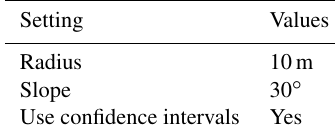
Table A4. SAGA-GIS DTM filter tool settings.